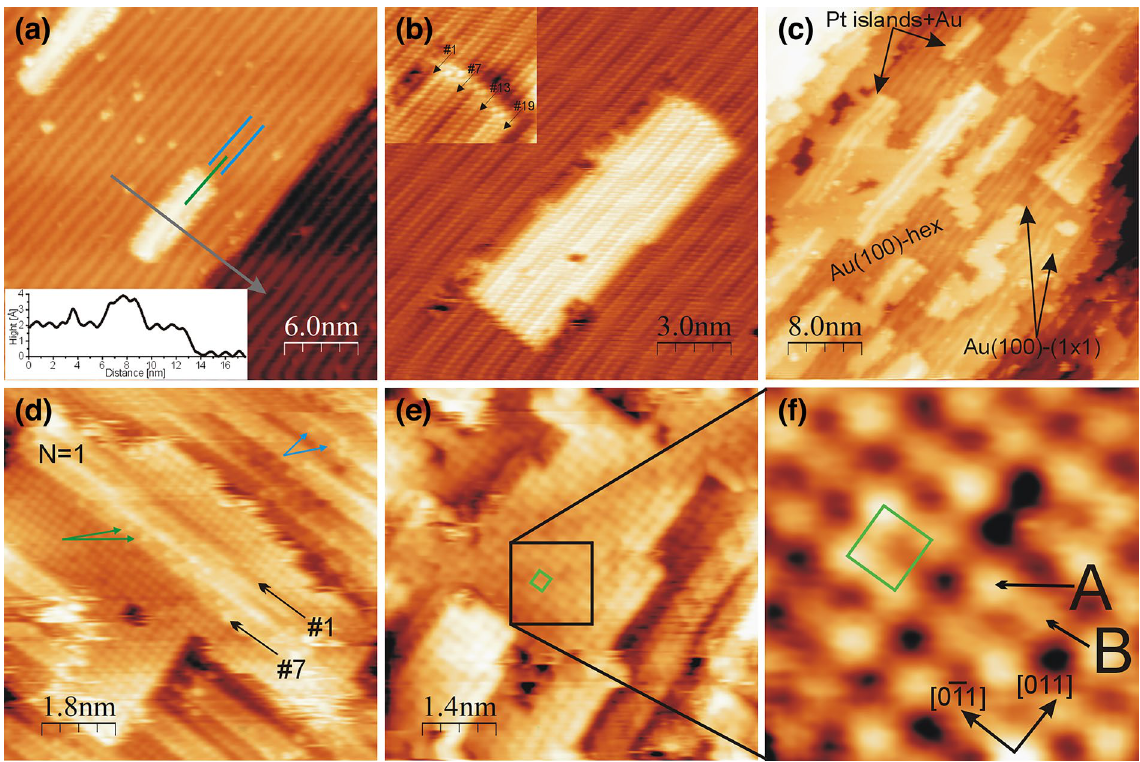
Figure 1. STM images of Au(100) after deposition of: (a) 0.05 ML Pt; (b) layer from (a) after subsequent annealing at 50, 80 and 100 °C for 10 min; (c,d) 0.3 ML; (e,f) 0.5 ML Pt. Taken for: (a) U = + 758 mV; I = 2.1